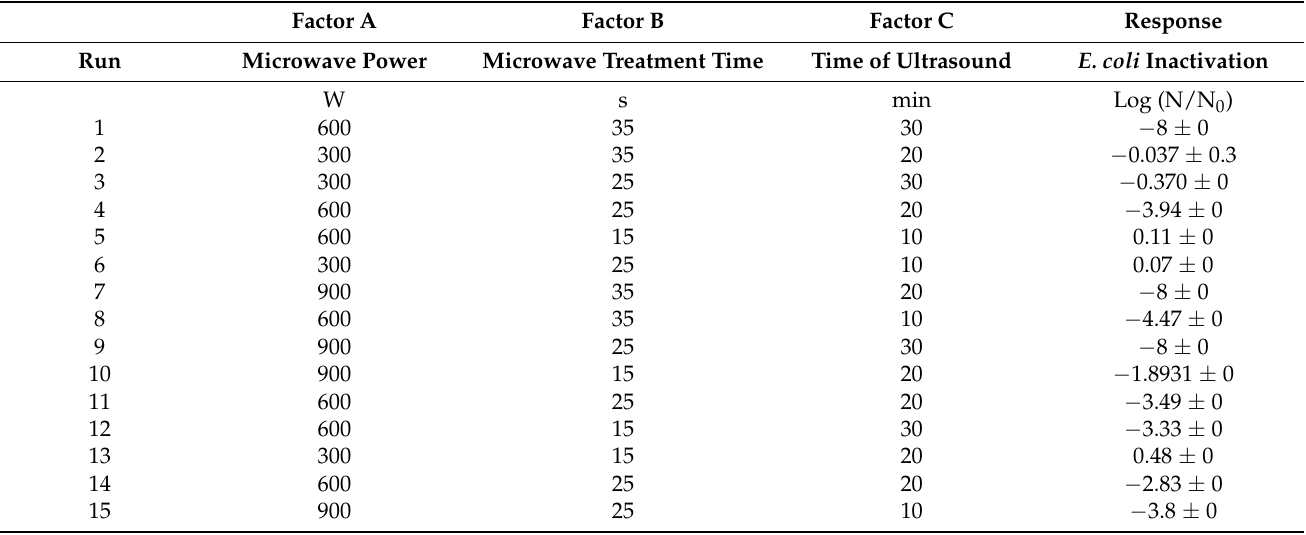
Table 2. Plan for the experimental design and related BBD responses based on RSM for E. coli inactivation.